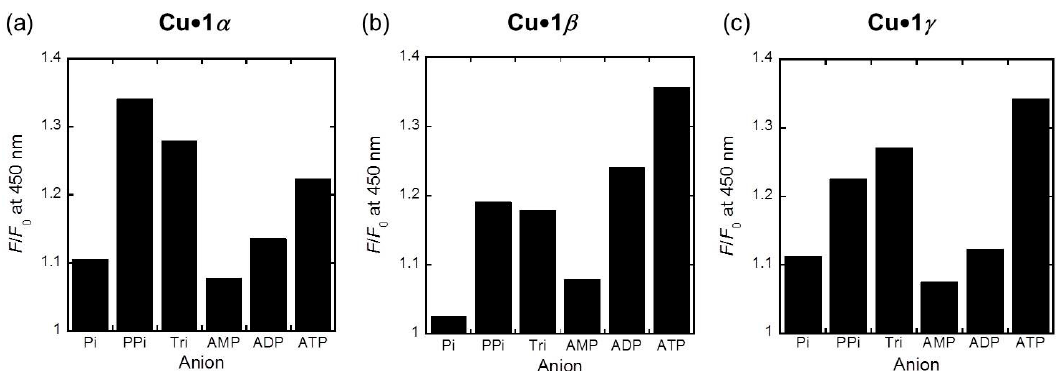
Figure 4. Fluorescence responses of ( a ) Cu·1 α , ( b ) Cu·1 β , and ( c ) Cu·1 γ in the presence of phosphoric acid derivatives in water, pH 6.4 adjusted by PIPES/NaOH buffer, at 25 °C ( λ ex = 404, 408, 408 nm). [ 1 α , 1 β , or 1 γ ] = 0.010 mM, [Cu(NO 3 ) 2 ] = 0.010 mM, [phosphoric acid derivative] = 1.0 mM.